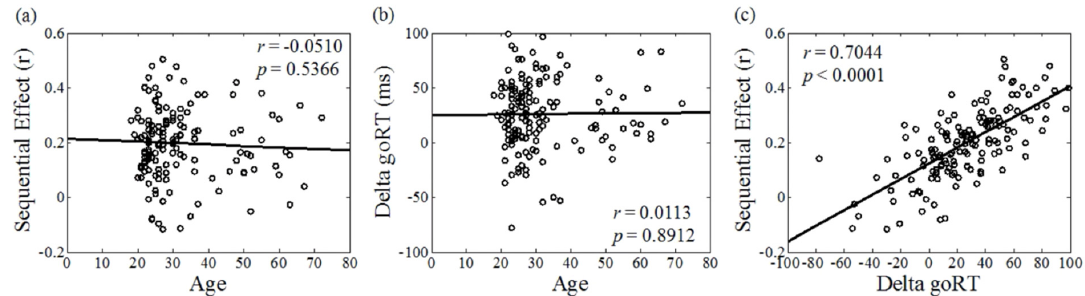
Figure A2. Correlation between ( a ) age and proactive control represented by the sequential effect quantified as the correlation between the estimated probability of stop signal and go reaction time (goRT) (a reproduction of Figure 1a in Hu et al. [45]); ( b ) age and proactive control represented by the delta goRT quantified as the difference between goRT of go trials following stop trials and those of go trials following go trials described in Soltanifar et al. [87]; and ( c ) the two proactive control indices.